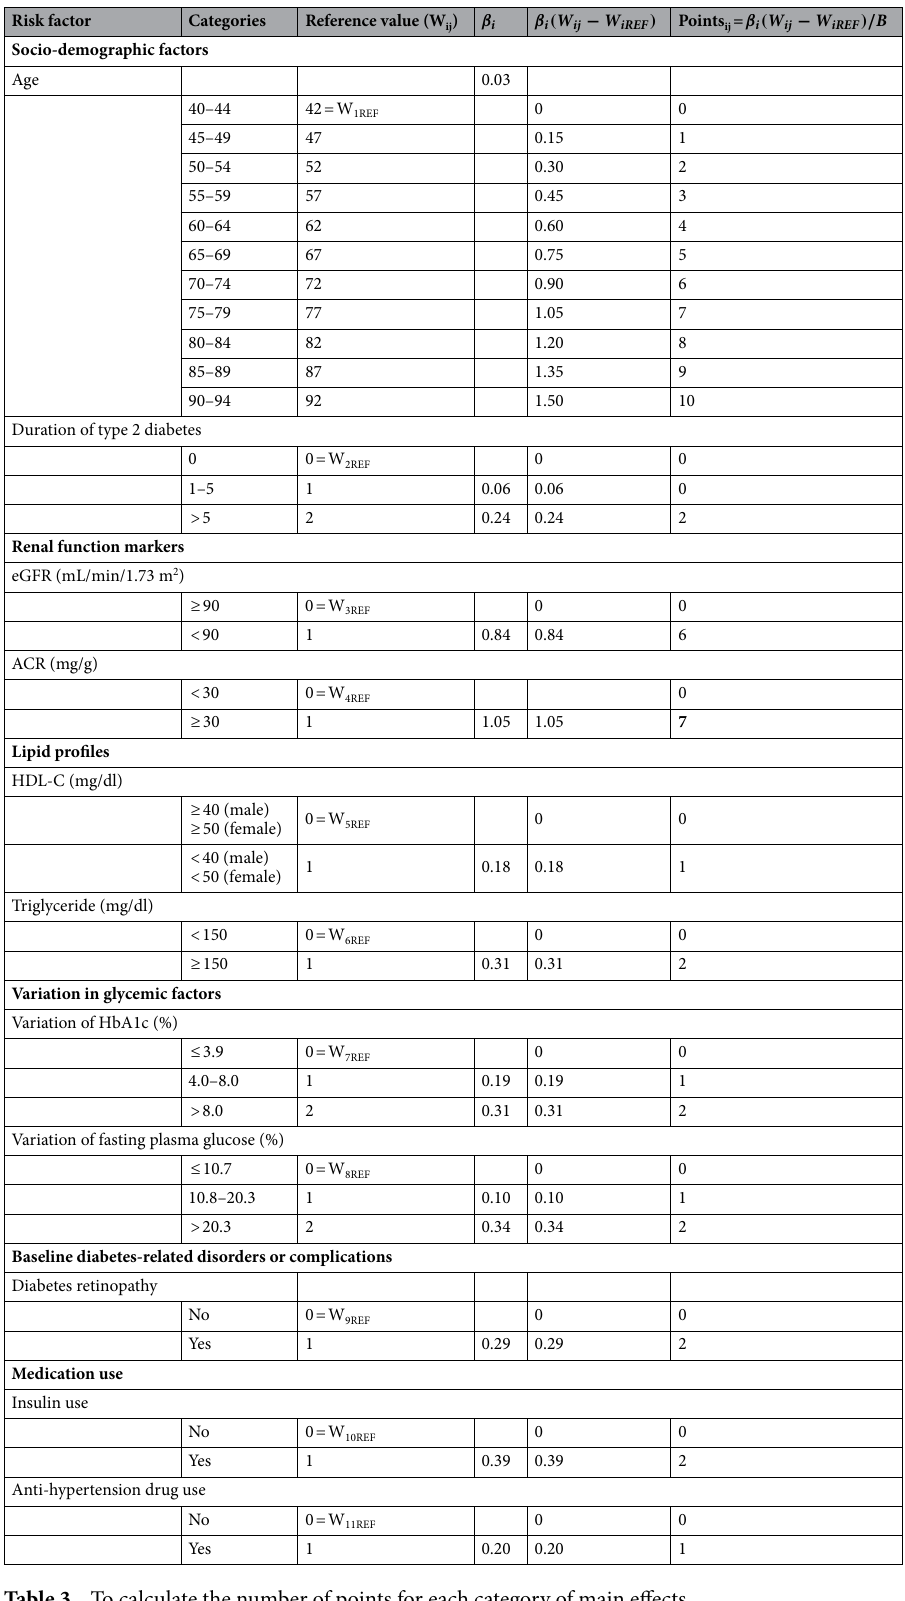
Table 3. To calculate the number of points for each category of main